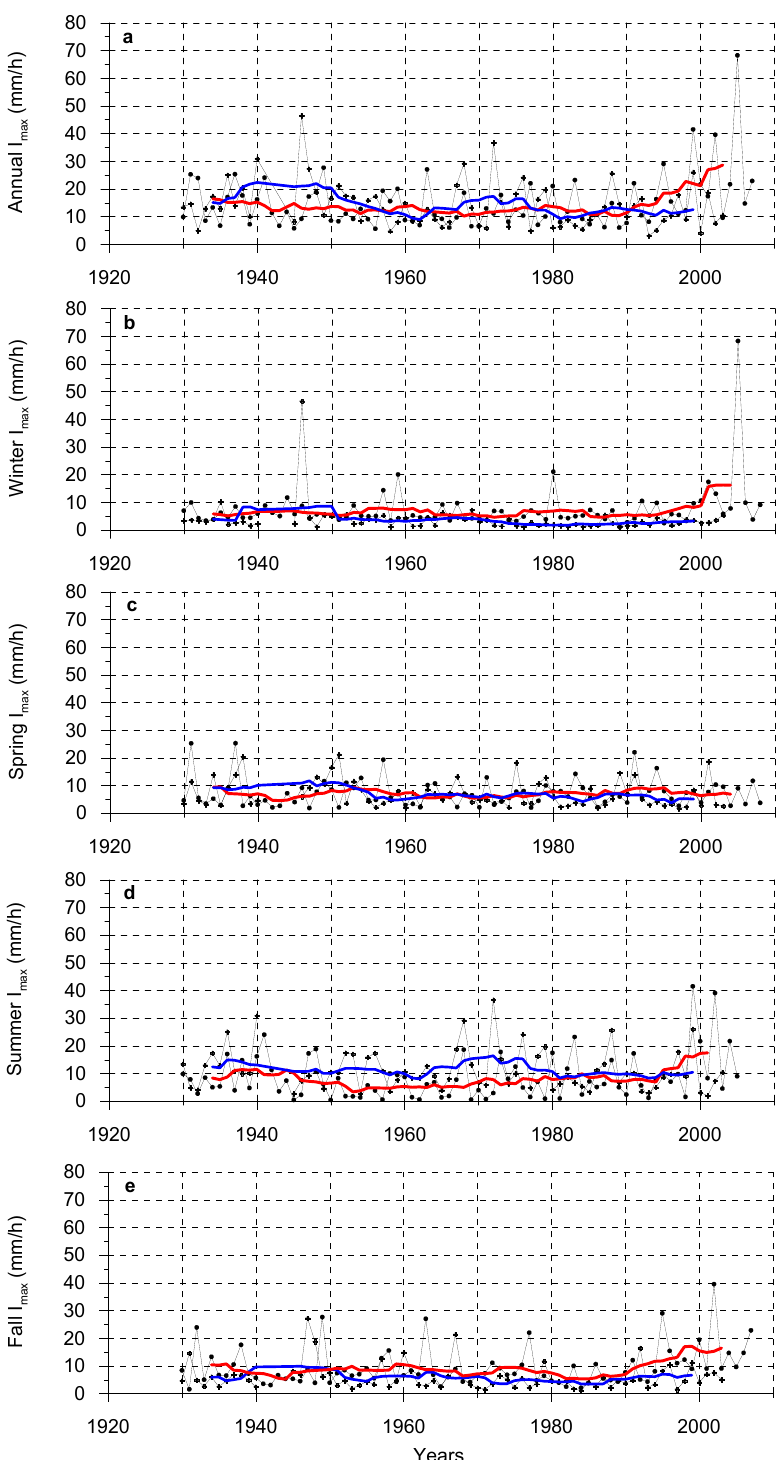
Figure 4. Time series of annual and seasonal maximum rain intensity I max for NOA ( ● circle) and AUTH (+cross). Red (NOA) and blue (AUTH) curves represent the Gaussian 9 fitting filter. Fig. 4. Time series of annual and seasonal maximum rain intensity I max for NOA ( • circle) and AUTH (+ cross). Red (NOA) and blue (AUTH) curves represent the Gaussian 9 fitting